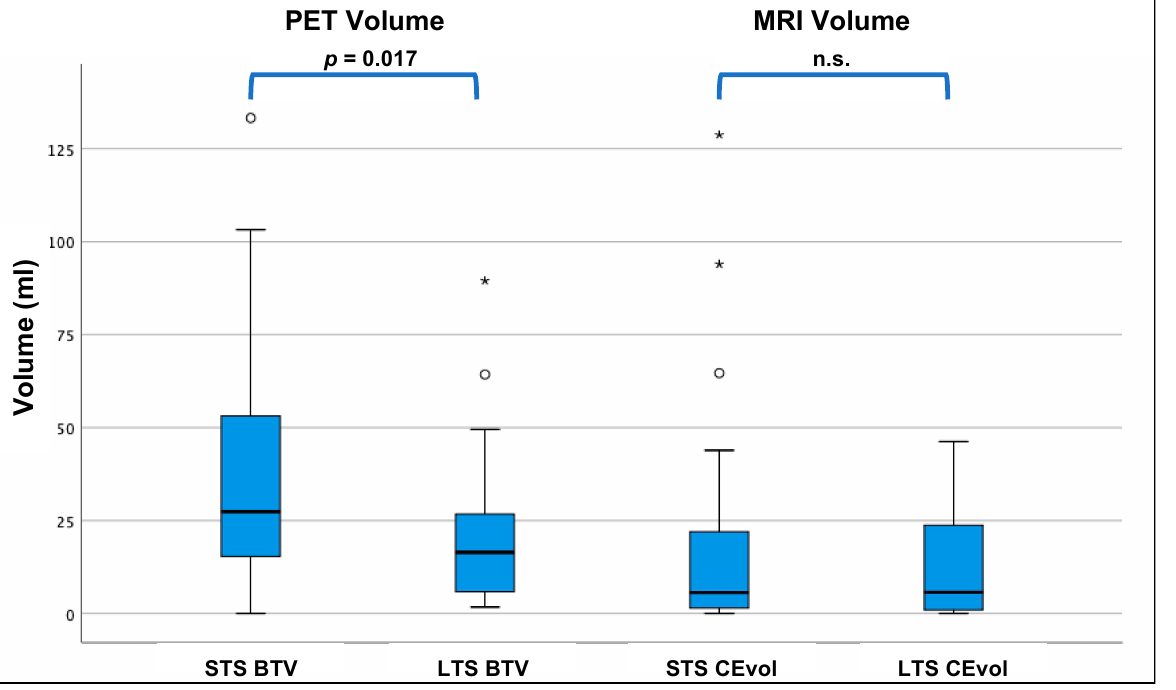
Figure 1. Comparison of PET-based and MRI-based tumour volumes in LTS vs. STS: the PET-based BTV was significantly smaller in the LTS group compared to the STS group (16.5 vs. 27.4 mL; p = 0.017), whereas the volume of CE (CEvol) on MRI was comparable between STS and LTS (5.7 vs. 5.8 mL, p = 0.802). */° = outliers. N.s. = not significant.